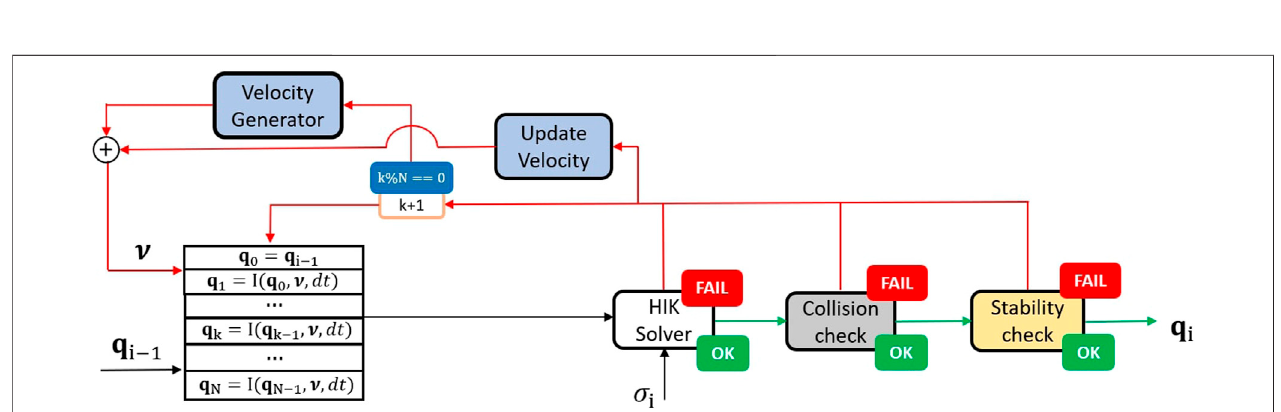
FIGURE4| NSPG fl owdiagram:thecon fi guration q i − 1 isusedasanominalposturefortheHIKsolver,andateachiteration,itismodi fi eddependingontherandom velocityvector ν generated,untilafeasiblecon fi gurationisfound.Ateachiteration,thevelocityvector ν isupdatedfollowing Section5.4 .Noticethatthenominalposture is reset to q i − 1 every N iterations. σ i de fi nes the manifold for the HIK solver, while green and red arrows de fi ne the fl ow when the validity checks and the HIK projector succeed or fail, respectively.